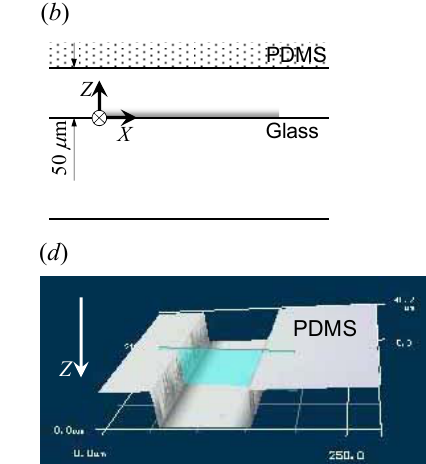
Figure 5. Schematic of ( a ) top, ( b ) side and ( c ) cross-sectional views of the I-shaped microchannel. ( d ) The width and depth of the PDMS microchannel were measured by a 3D laser scanning